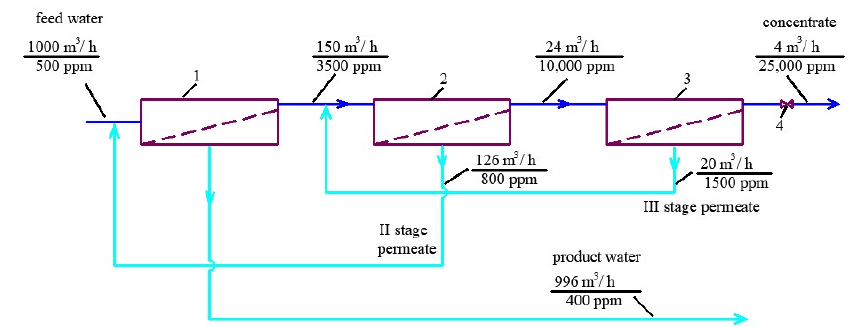
Figure 3. Principles of reducing the volume of concentrate by 100–200 times during natural water treatment using low rejection nanofiltration membranes: 1—the first ‐ stage membrane module; 2— ter treatment using low rejection nanofiltration membranes: 1—the first-stage membrane module; the second ‐ stage membrane module; 3—the third stage membrane module. 2—the second-stage membrane module; 3—the third stage membrane